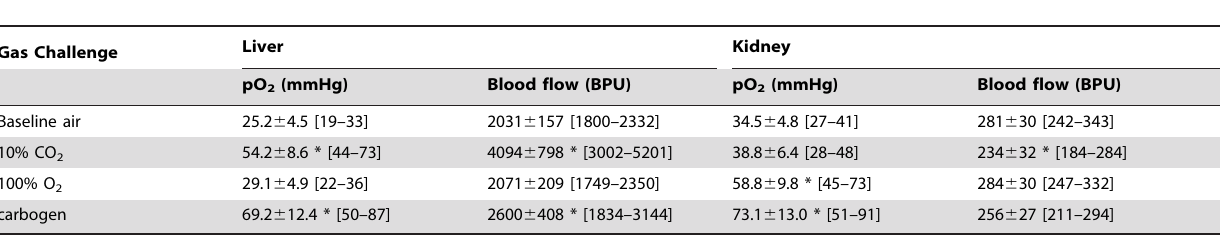
Values are mean 6 SD ( N =12). Range in square brackets. Abbreviations: pO 2 , tissue oxygen tension; BPU, blood perfusion units. Gases: air (21%O 2 , balance N 2 ), 10% CO 2 (balance air), carbogen (90% O 2 + 10% CO 2 ). * P , 0.05 significantly different from baseline (air